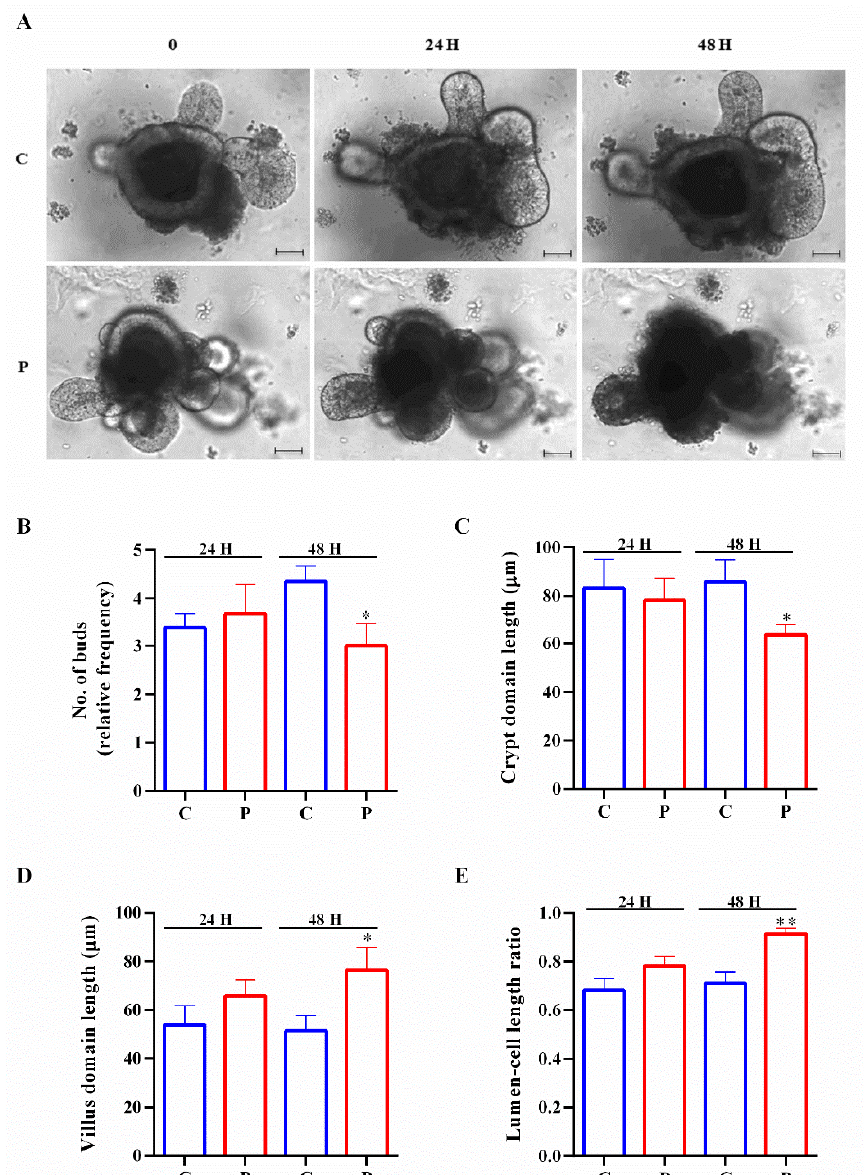
Figure 2. Lipotoxicity affects intestinal organoid growth. ( A ) Representative brightfield images of intestinal organoids following 0.5 mM palmitate exposure for 24 and 48 h. Scale bar, 50 µ m. Number of buds ( B ), crypt domain length ( C ), villus domain length ( D ) and lumen–cell length ratio ( E ) in controls and treated organoids ( n = 6). Data are expressed as means ± SD. Unpaired Student’s t test: * p < 0.05, ** p < 0.01. C, control; P, palmitate.